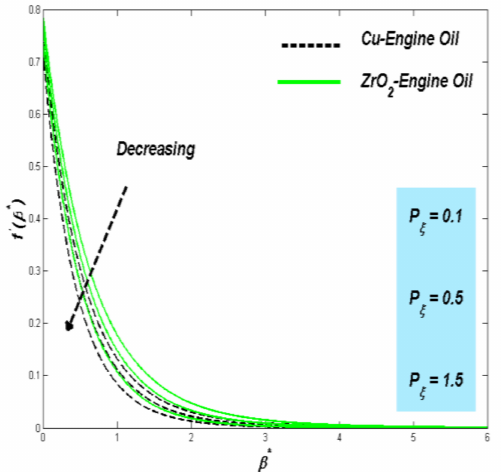
Figure 14. Velocity profile change with P ξ .